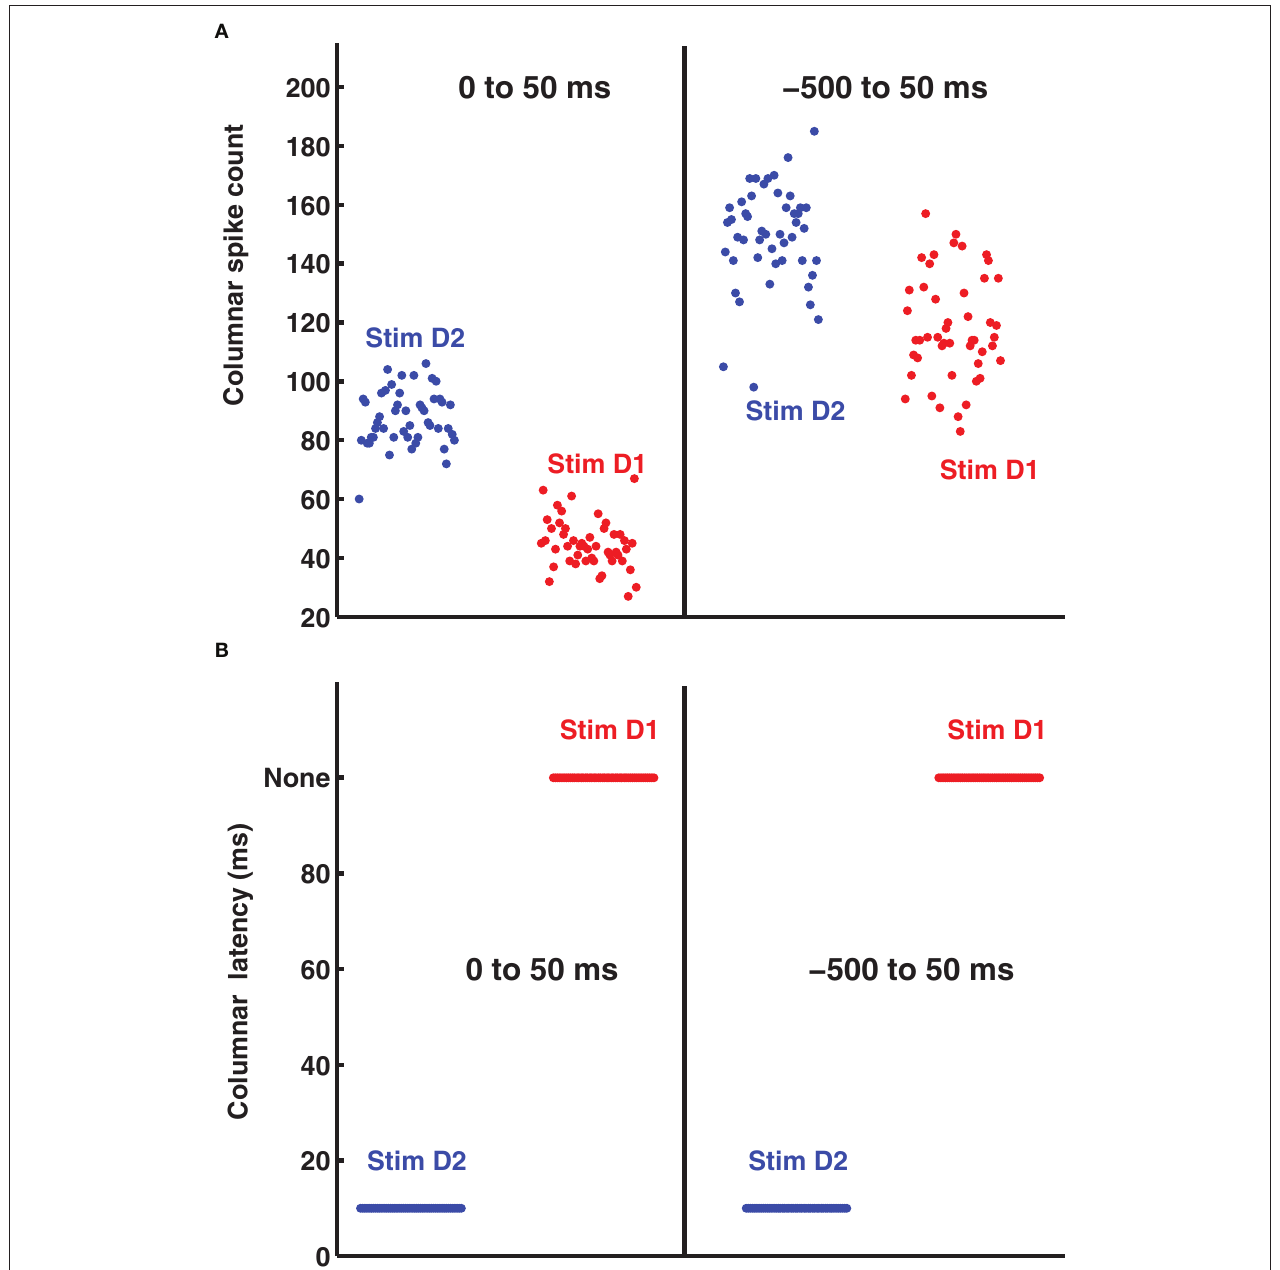
Figure 3 | The distribution of single trial D2-columnar spike counts and of columnar latencies. (A) Reports the scatter plot of the single-trial summed spike count of a population of 100 neurons in barrel D2 over all the trials available to deflection of whisker D2 (blue dots) and whisker D1 (red dots). The left and right part of (A) report respectively the spike counts obtained in the 0 to 50 ms and − 500 to 50 ms peri-stimulus window